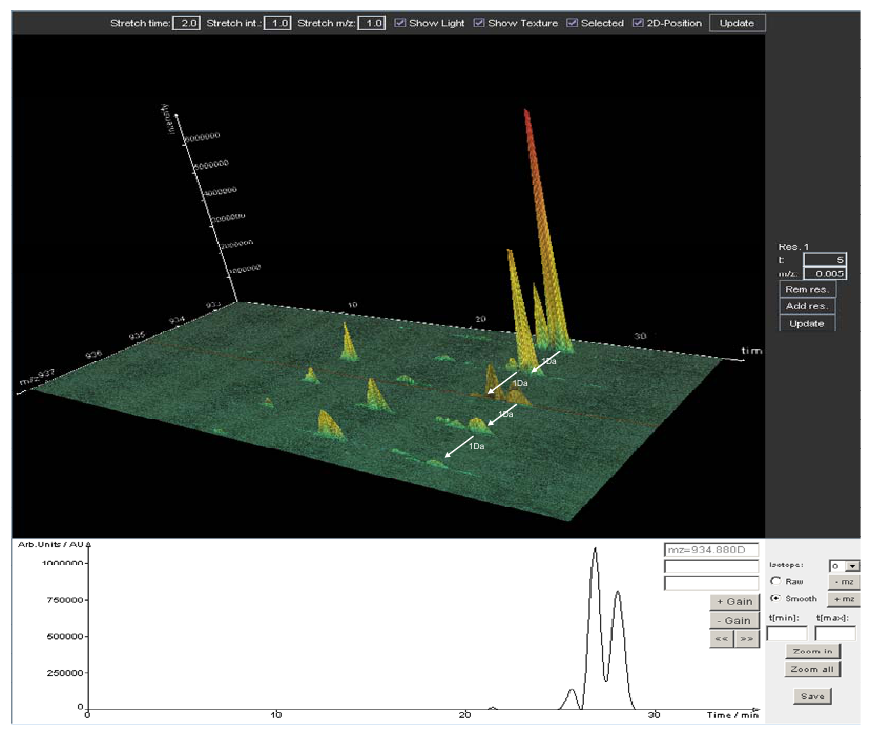
Figure 5. 3D plot ( m/z , retention time, intensity) of high resolution LTQ-FT data generated by Lipid Data Analyzer. Depicted are TG 56:1 and TG 56:2, including their isotopic distribution. Unambiguous identification of elemental composition is accomplished by a 3D algorithm which relies on the combination of accurate mass, retention time and isotopic pattern. The lower panel shows a 2 D plot (retention time, intensity) of m/z 934.88. The M + 2 peak of TG 56:2 cannot be resolved from TG 56:3 by the mass extraction window chosen, but only by retention